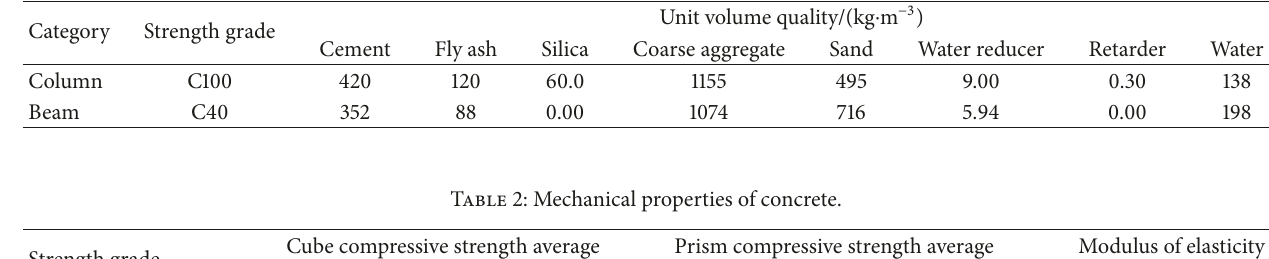
Table 1: Concrete content.